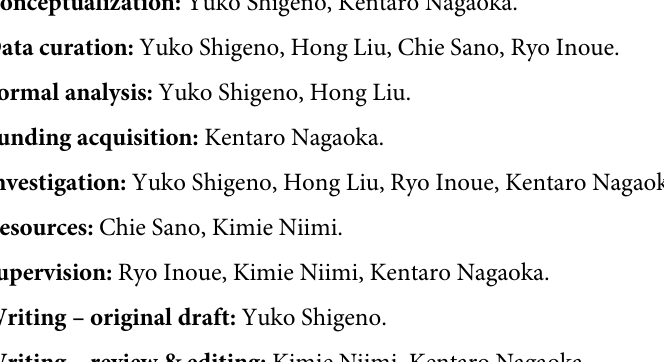
S1 Table. List of anovulatory individuals. S2 Table. Relative abundance and prevalence of bacterial features shared in healthy female marmosets. S3 Table. Average similarity of inter-individual (individual variation) fecal microbiome among vendors. S4 Table. Genera correlated with plasma progesterone